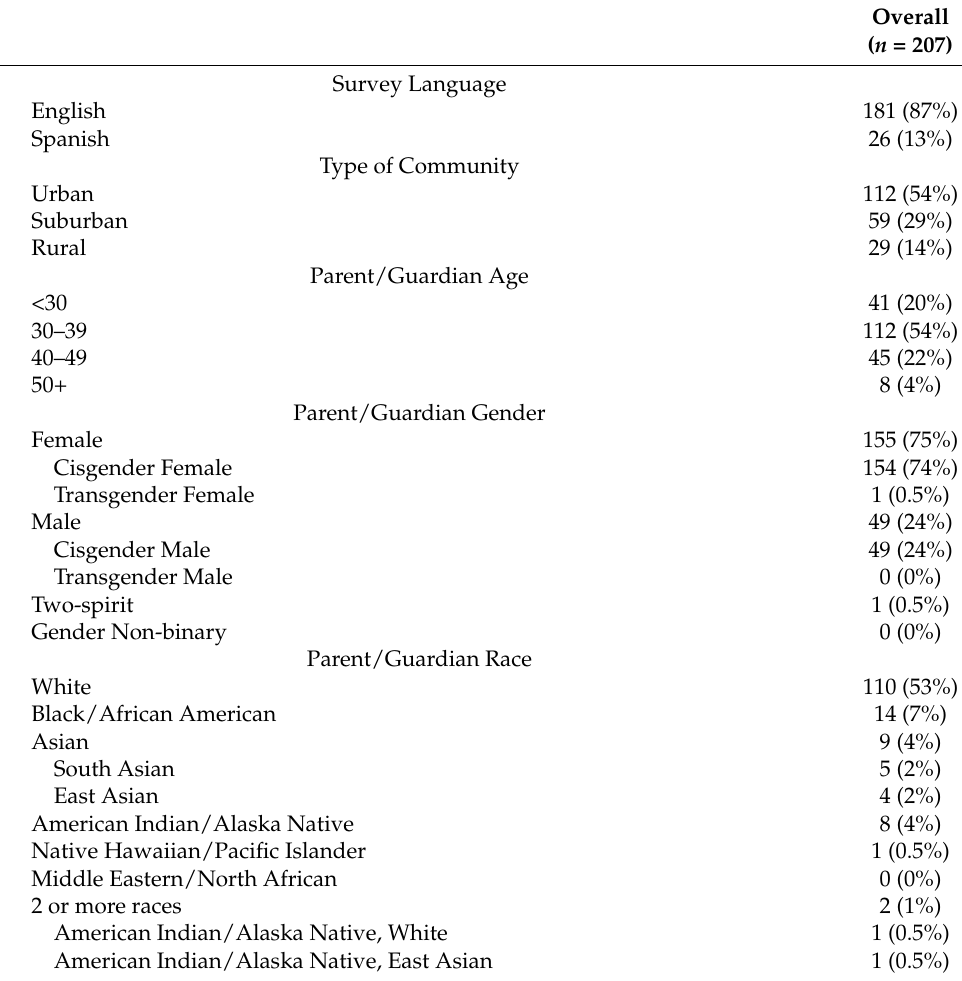
Figure 1. Geographic Distribution of Survey Responses. Categories of response numbers were created using Jenks Optimization. Table 1. Parent/guardian characteristics.